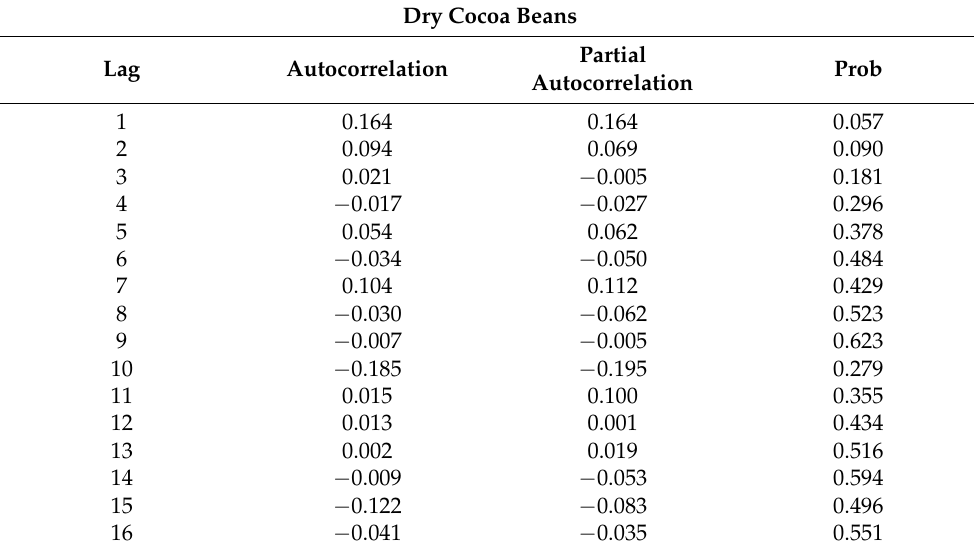
Table 3. Autocorrelation and partial autocorrelation values for differenced Dry Cocoa Beans price